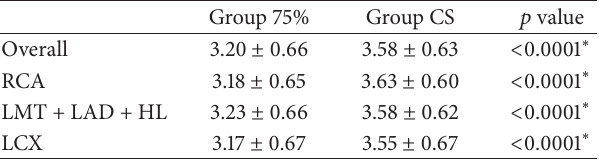
Table 4: Subjective image quality.